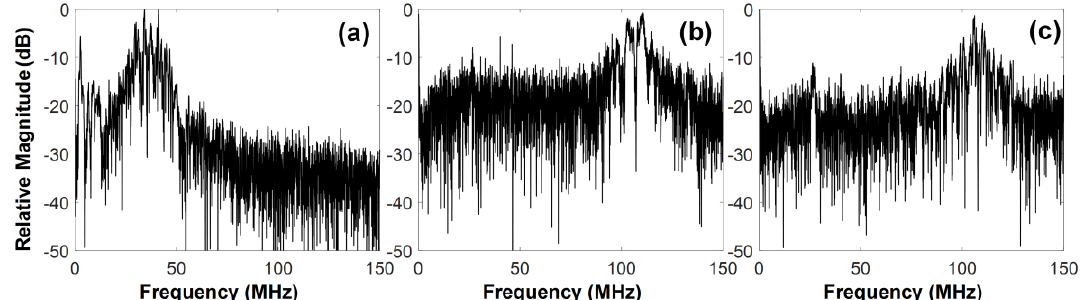
Figure 13. Frequency spectra of one scanline signal of the images in Figure 10: ( a ) 35-MHz and ( b ) 105-MHz fundamental imaging scanline, ( c ) third harmonic imaging scanline.